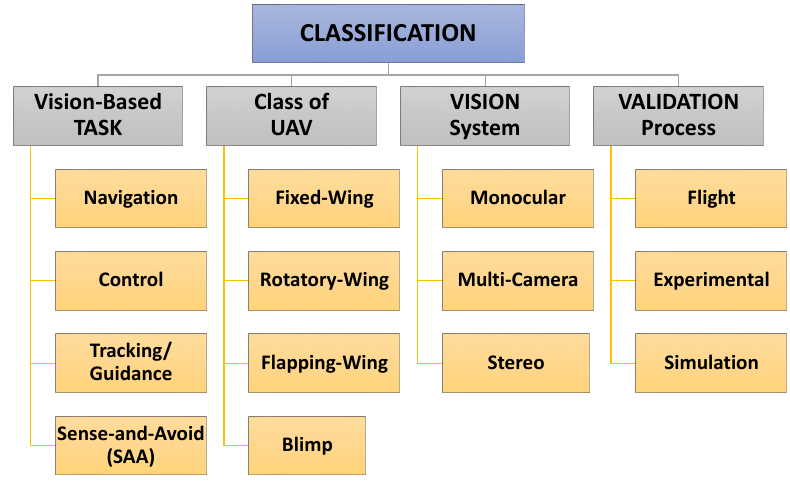
Figure 3. Classification